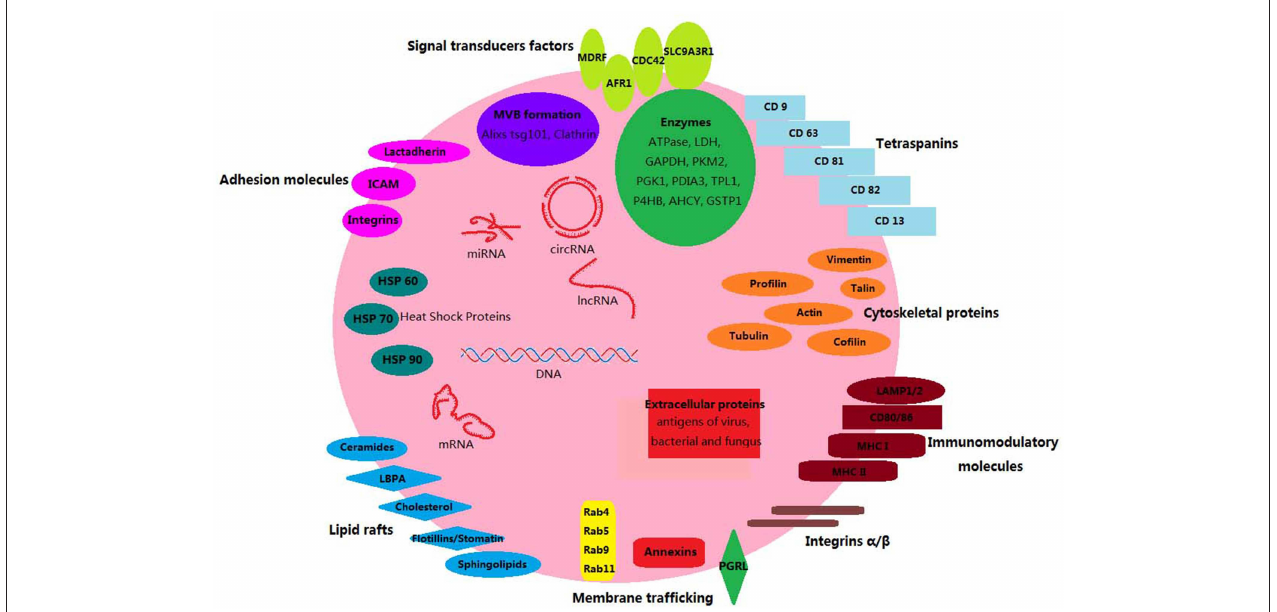
FIGURE 1 | Components of mammalian exosomes. Exosomes are small membrane-bound vesicles. Their lipid bilayer contain typical transmembrane proteins and receptors: tetraspanins (CD9, CD63, CD81, CD82, CD13); signal transduction factors (MDRF, AFR1, CDC42, SLC9A3R1); adhesion molecules (lactadherin, ICAM, integrins); membrane trafficking proteins (annexins, Rabs, PGRL proteins); lipid raft-associated molecules (lbpA, lyn, flotillins/stomatin, cholesterol, sphingolipids); immunomodulatory molecules (LAMP1/2, CD80/86, MHC-I, MHC-II). Luminal proteins have stabilizing, structural, and metabolic functions: HSPs (Hsp60, Hsp70, and Hsp90), cytoskeletal (vimentin, profilin, talin, actin, tubulin, cofilin), enzymes (ATPase, GAPDH, LDH, etc.), MVB biogenesis (alixs, tsg101, clathrin). Other EV components include DNA, mRNAs, miRNAs, cirRNAs, and